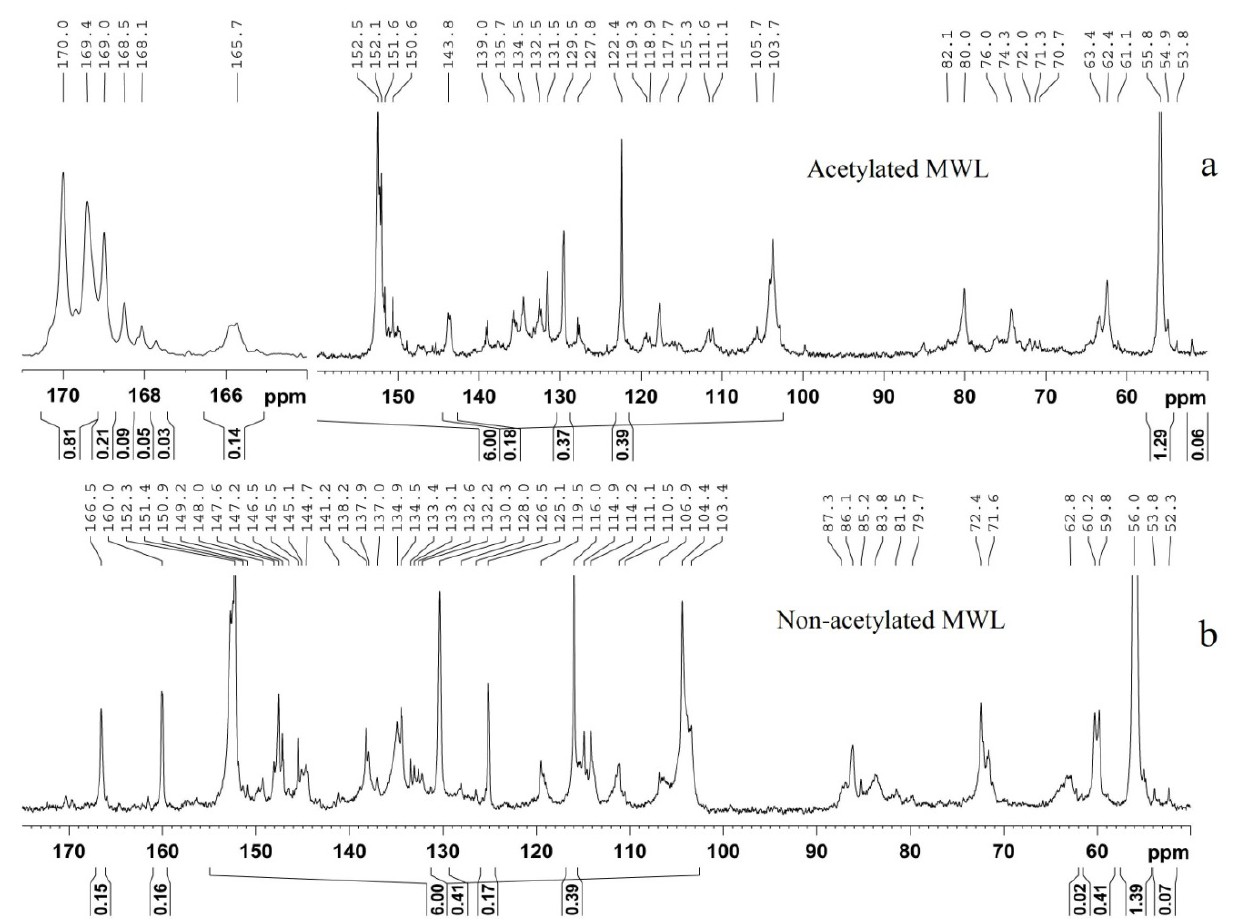
Figure 2. 13 C-NMR spectra of acetylated and non-acetylated bamboo lignin samples (Reprinted from [28]. Copyright 2013 De